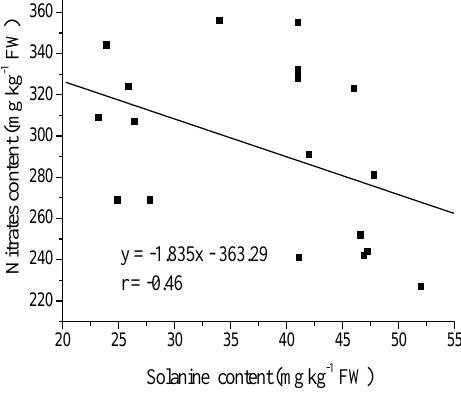
Figure 6. The significant relationship between the total glycoalkaloid (TGA) content and nitrates contents in the potato tubers after 3 months of storage. R: p ≤ 0.05.